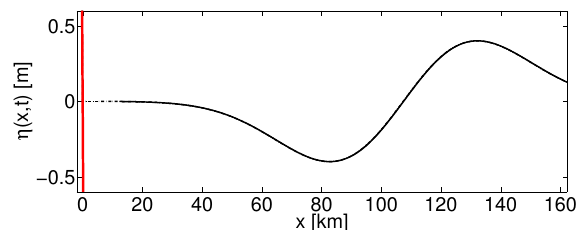
Fig. 15. The initial condition for the Aceh case is shown for the Figure 15. The initial condition for the Aceh case is shown for the linear model coupled to the NSWE (dashed and dotted-dashed lines) linear model coupled to the NSWE (dashed and dotted-dashed lines) and for the linear model with an EBC implementation (solid line). and for the linear model with an EBC implementation (solid line). The solid and dashed lines are on top of another. The solid and dashed lines are on top of one another.